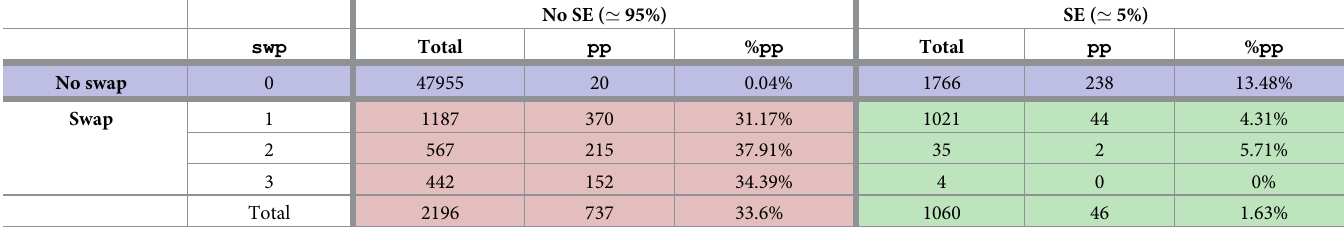
Table 1. Detailed count of each case occurrence. The No Swap cases (blue) do not count for the experimental condition evaluation as they represent the large majority of ‘normal’ events when playing the game. The pp columns represent the sub pedal pressed count per condition while the% pp represents its percentage share. In total, on the experimental conditions, 24% of the swaps were noticed with a pedal press (sum of pp over totals from red and pp over totals from green cells from the last